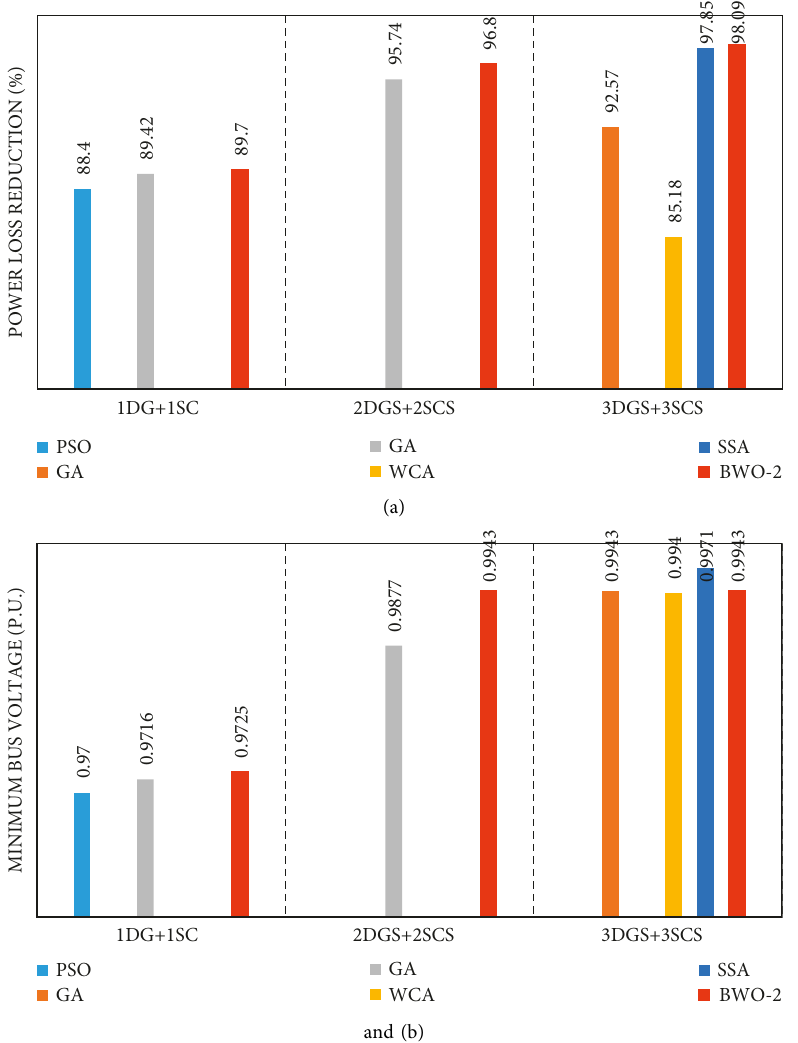
Figure 17: Performance comparison of BWO-2 against the established optimization algorithms for (a) power loss reduction and (b) minimum bus